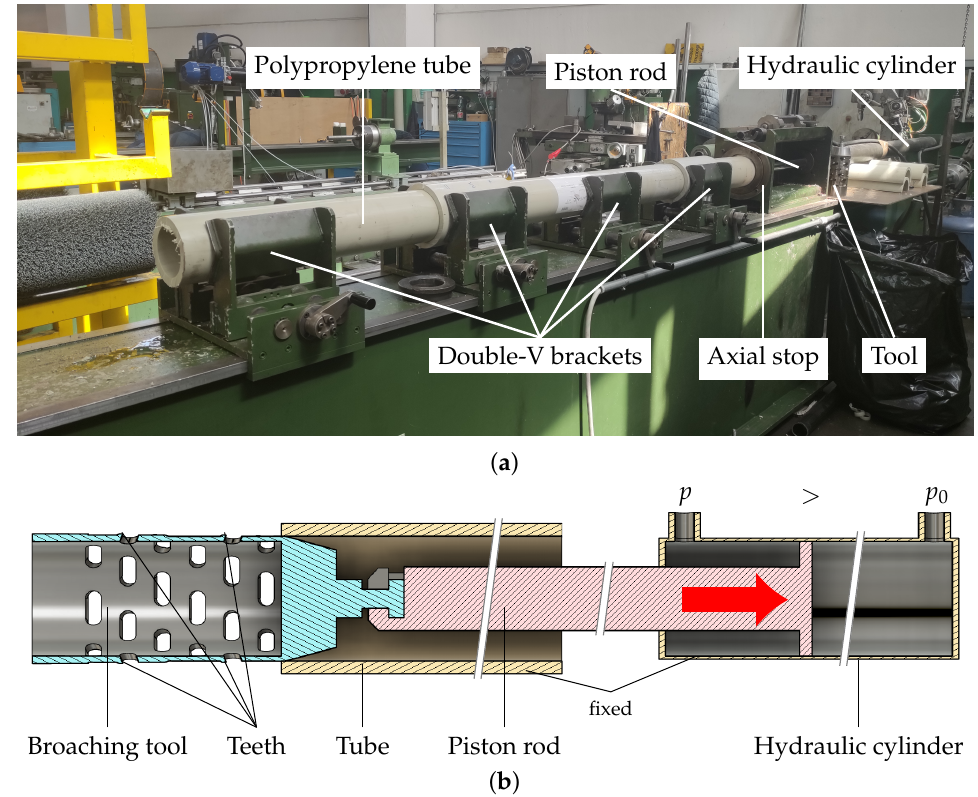
Figure 2. Hydraulic broaching: ( a ) Machine on the shop floor with mounted polypropylene tube to be broached; ( b ) Scheme of the working principle of the hydraulic broaching